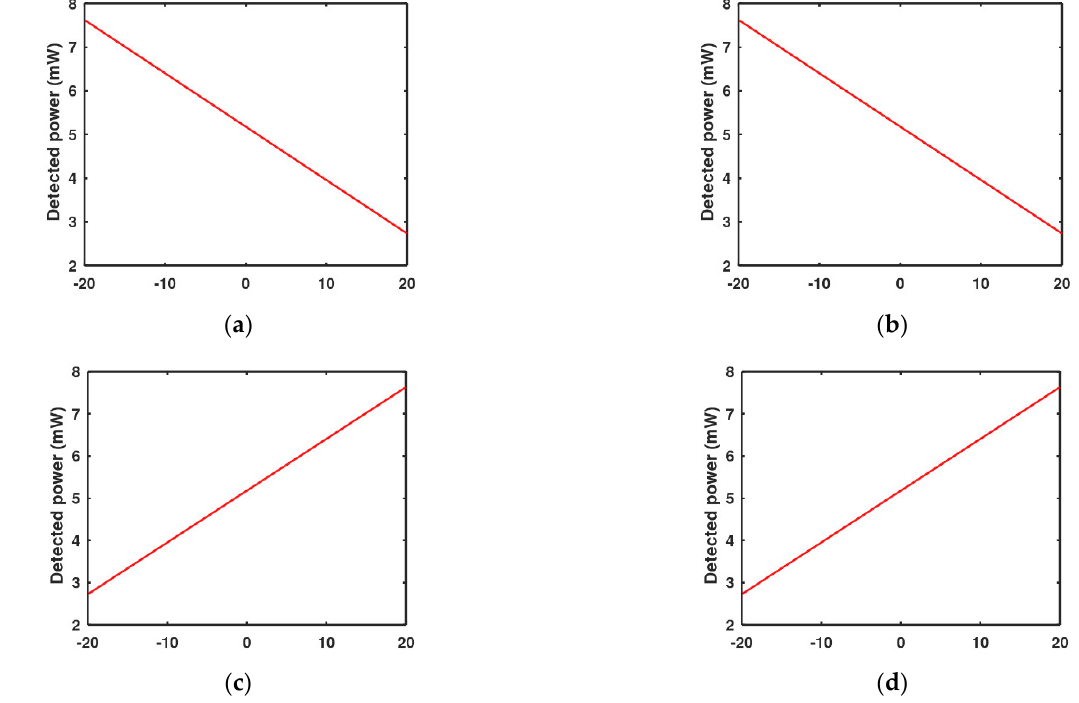
Figure 11. Detected power change with the lateral movement for each quadrant of the QPD: ( a ) The left upper quadrant, ( b ) the right upper quadrant, ( c ) the left lower quadrant, ( d ) the right lower quadrant.